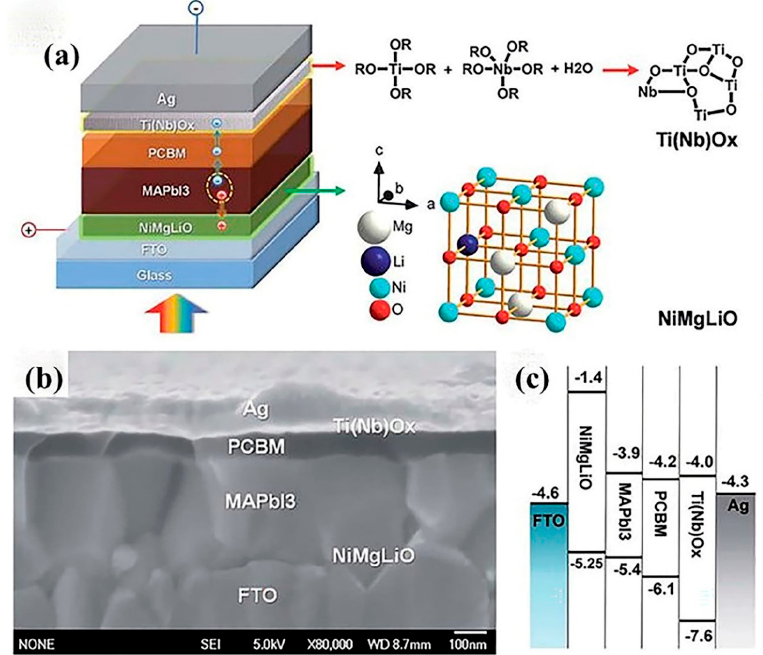
Figure 21. The PSCs’ structure and band alignments: ( a ) Diagram of the cell configuration highlight- ing the doped charge carrier extraction layers. ( b ) A high-resolution cross-sectional SEM image of a complete solar cell. ( c ) Band alignments of the solar cell [153]. Copyright 2015 American Association for the Advancement of Science.